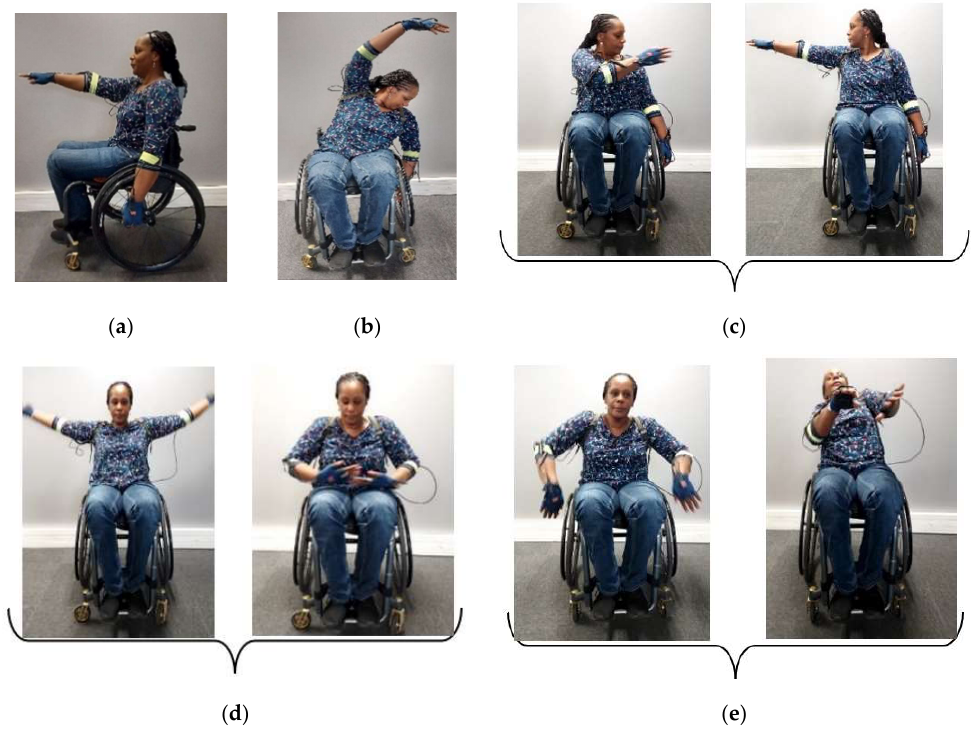
Figure 6. Wheelchair contemporary dance gestures (Gladys Foggea). The gestures are named as follows: ( a ) left/right hand forward, ( b ) left/right arm in curve, ( c ) throwing left/right hand, ( d ) opening and closing, and ( e ) rotation of trunk.